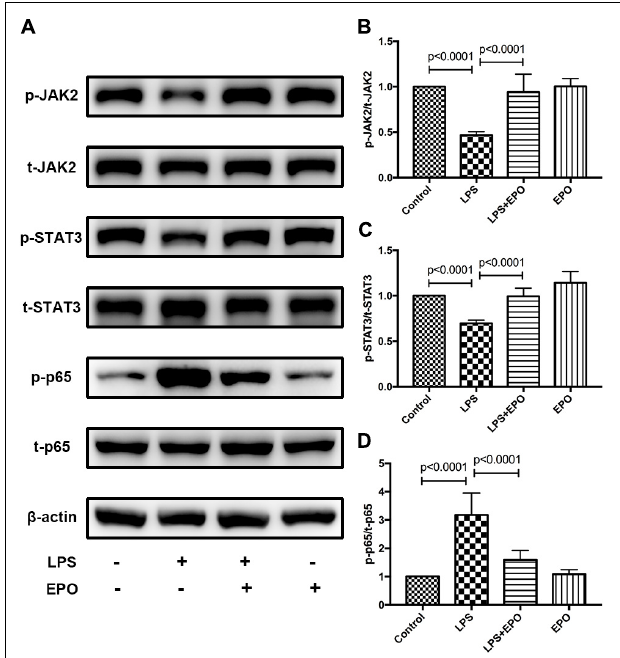
FIGURE 4 | EPO activated the EPOR/JAK2/STAT3 pathway and inhibited NF- κ B activation in LPS-induced ALI. EPO (5 U/g) was injected into the peritoneal cavity of mice after LPS (15 mg/kg) stimulation, and the mice were sacrificed 8 h later. The lung tissues were harvested to measure the protein expression levels of p-JAK2, t-JAK2, p-STAT3, t-STAT3, NF- κ B p-p65, and NF- κ B t-p65 (A–D) by Western blotting. The data are presented as the mean ± SD. The differences among groups were assessed by one-way ANOVA and the post hoc test (Turkey method) was applied to investigate the differences one by one. n = 8 per